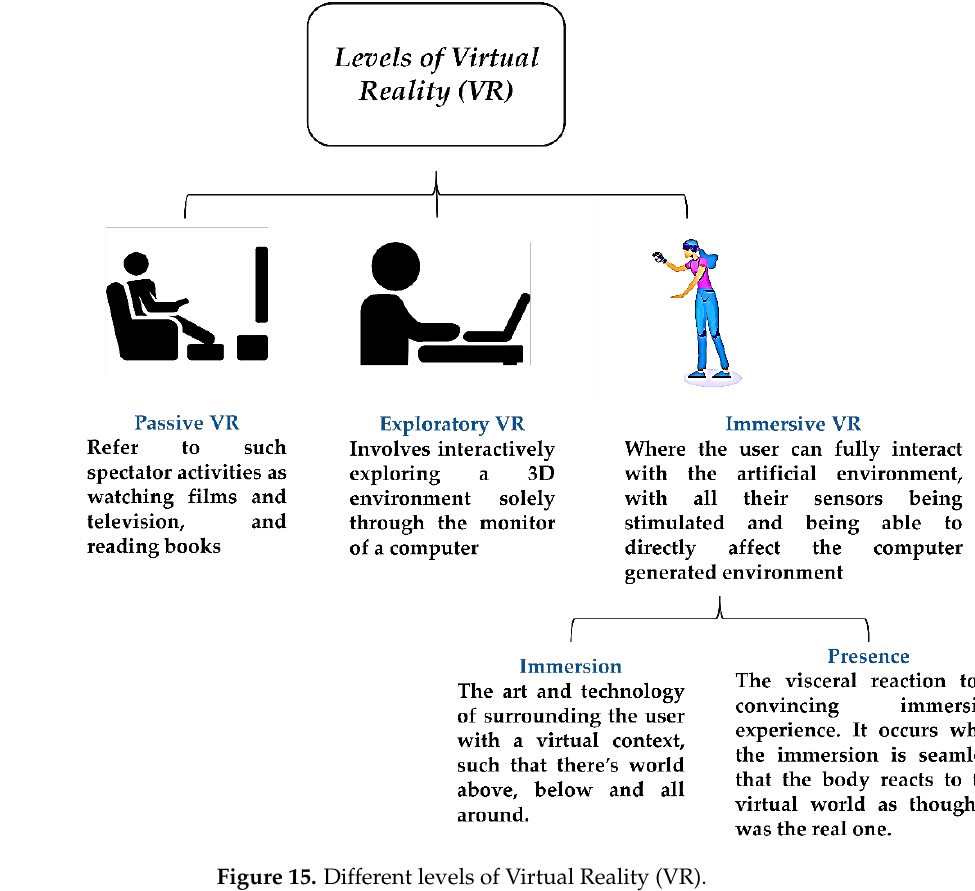
Figure 15. Different levels of Virtual Reality (VR).